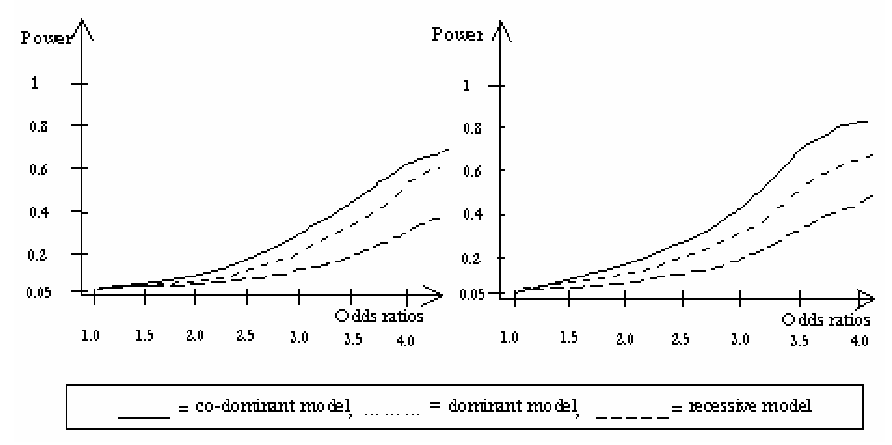
Figure 6 – Cases = controls = 50, f = 0.05. Figure 7 – Cases = controls = 100, f =